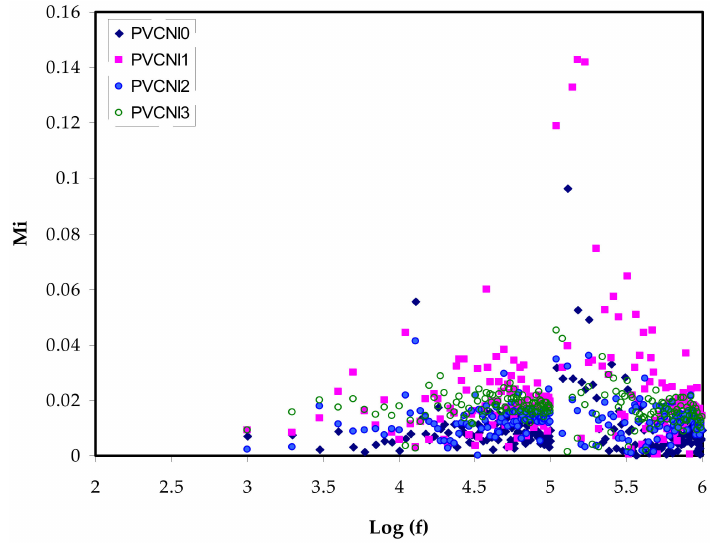
Figure 9. M i versus log ( f ) for all the electrolyte samples.